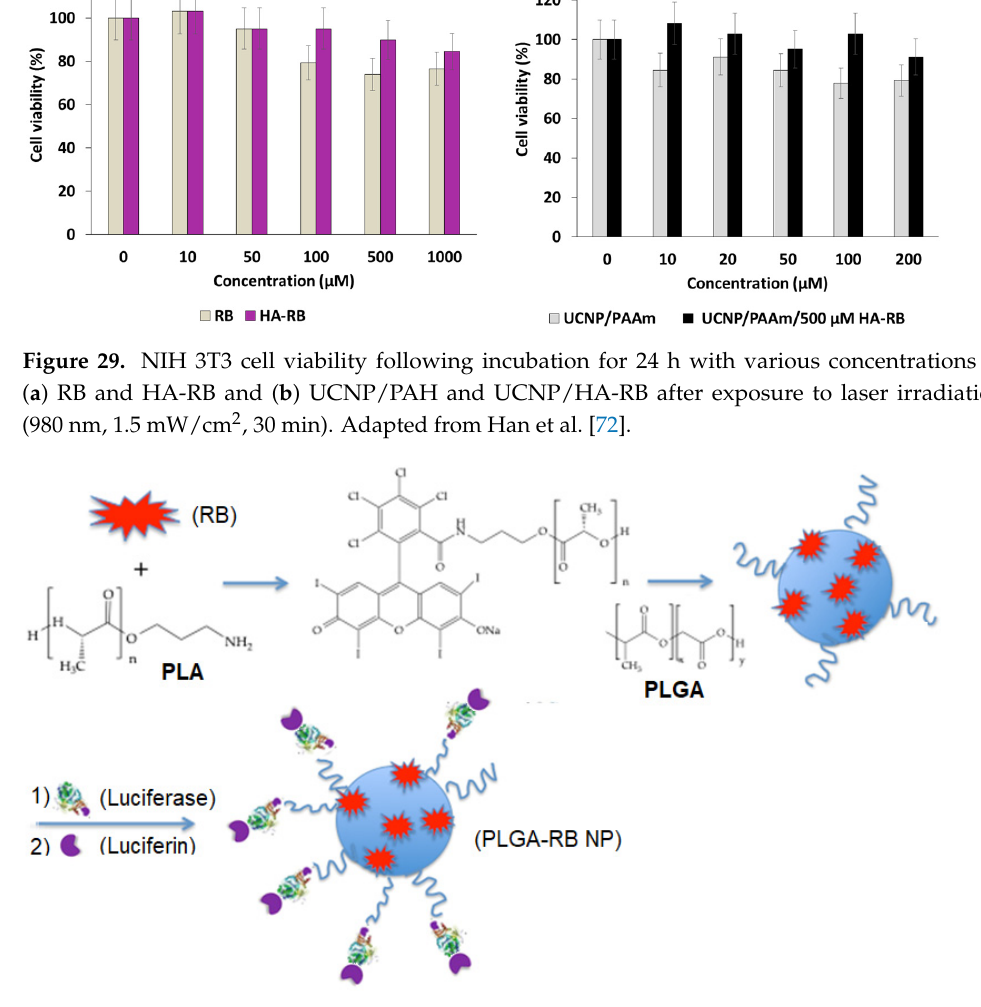
Figure 30. Preparation of PLGA-RB NPs for BRET-PDT. Adapted from Yang et al. [73].